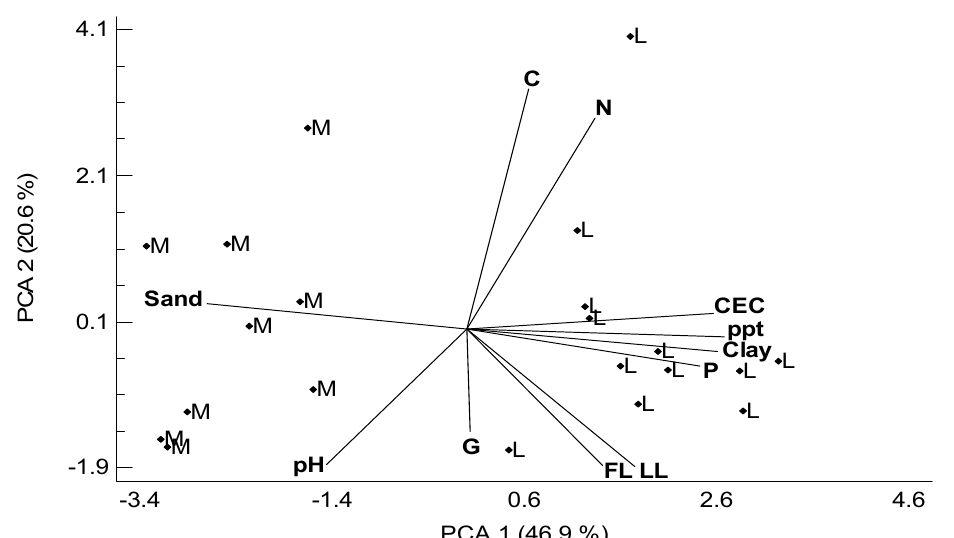
Figure 5. Correlation between the two components (PC 1 and PC 2) derived from two Principal Component Analyses of the landscapes in Magdalena, Colombia. M: Mountain landscape; L: Lomerio landscape; C: soil carbon content; P: Available soil P; ppt: precipitation; N: soil nitrogen content; CEC: cation exchange capacity; G: stand basal area; FL: total fine litterfall; LL: total leaf litter; ppt: precipitation.